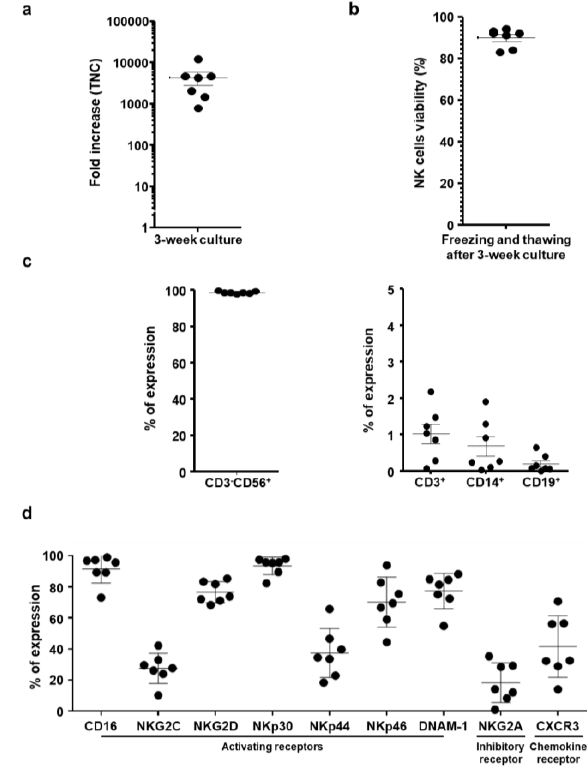
Figure 1. Characteristics of expanded and frozen natural killer (NK) cells. ( a ) The fold change in total nucleated cell count (TNC) of ex vivo -expanded NK cells between day 0 and day 21 of expansion. ( b ) Cell viability of cryopreserved NK cells after thawing. The viability of NK cells was evaluated by staining with propidium iodide to detect dead cells. % viable cells = number of viable cells / initial population frozen. ( c ) Purity of NK cells after thawing. The percent of cluster of di ff erentiation (CD)3 − CD56 + , CD3 + , CD14 + , and CD19 + cells were analyzed by flow cytometry. ( d ) Surface expression of activating receptors, inhibitory receptors, and chemokine receptors was analyzed by flow cytometry after NK cell expansion. Results indicate the percentage of reactive NK cells within each NK subset (n = 7). Data are representative of two independent experiments. Each dot represents the results from one